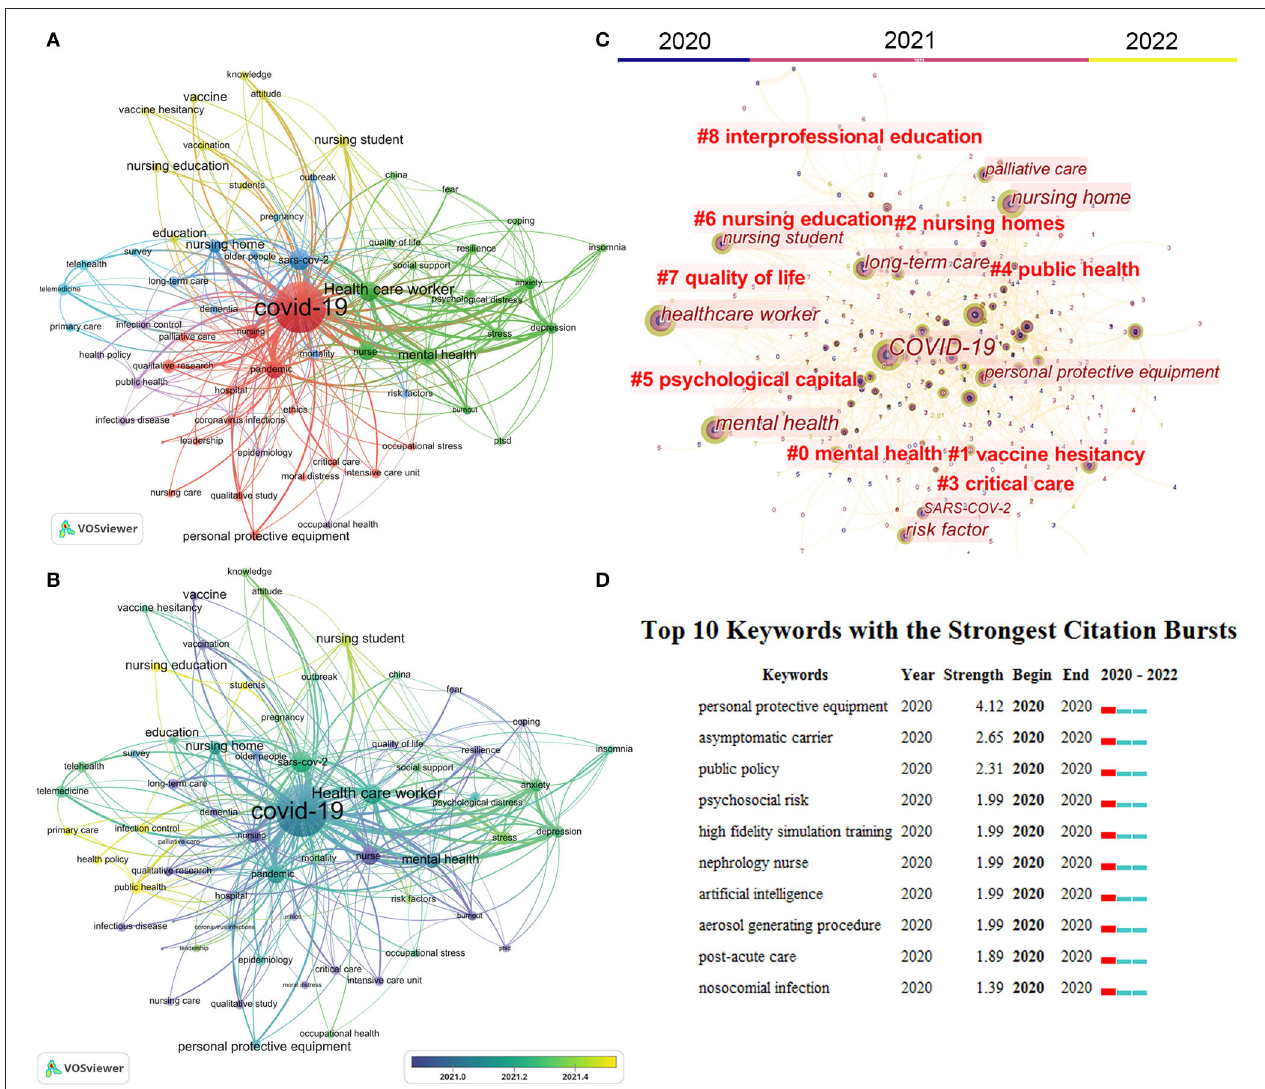
FIGURE 7 | Analysis of author keywords. (A) The co-occurrence networks of keywords are visualized by VOSviewer. Large nodes represented keywords with high frequency; the same color indicates closer relationships; (B) chronological overview of the co-occurrence network of author keywords. Dark blue refers to an earlier appearance, and yellow refers to the latest appearance. (C) Keywords clusters named by the CiteSpace LLR algorithm from 2020 to 2022. (D) Top 10 keywords with the strongest citation bursts. The red bar indicates the burst duration. The burst strength refers to the importance of the keyword to the research